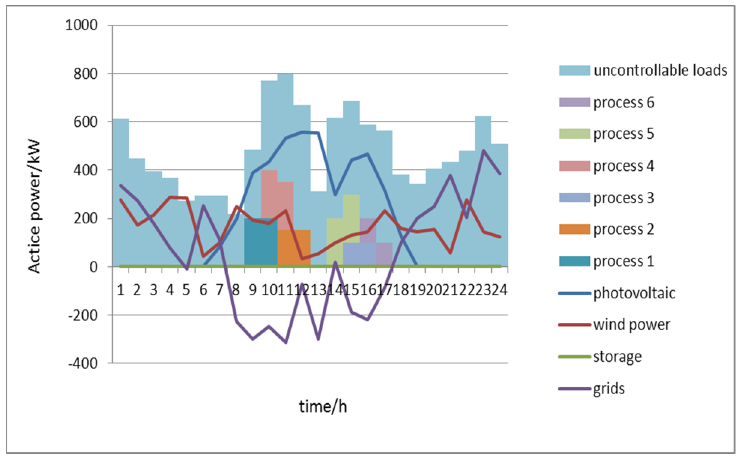
Figure 5. The stacked bars of the original loads and power curve of the distributed generation.